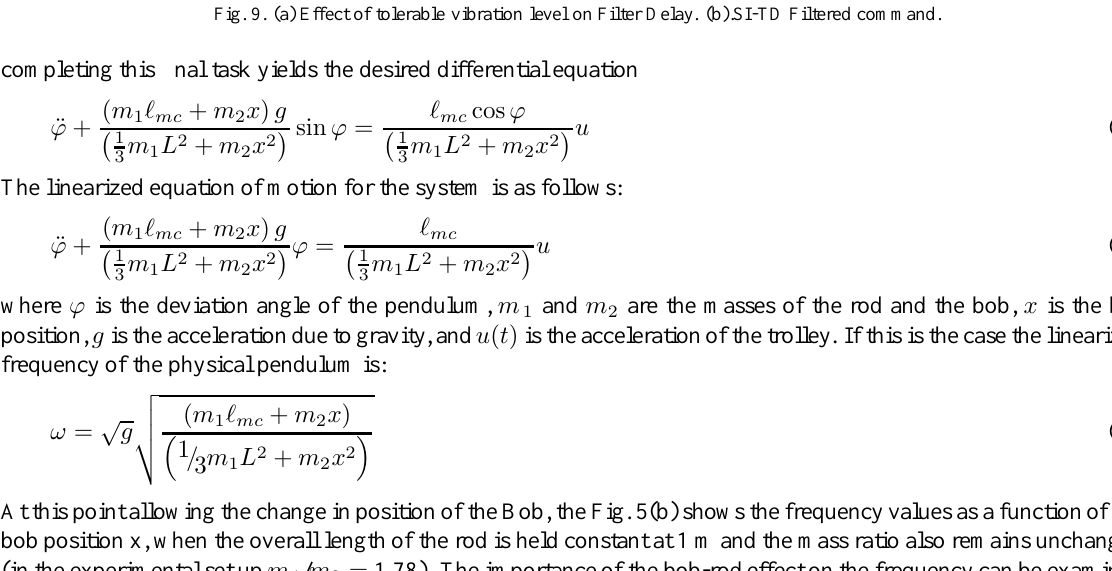
Fig. 9. (a) Effect of tolerable vibration level on Filter Delay. (b).SI-TD Filtered